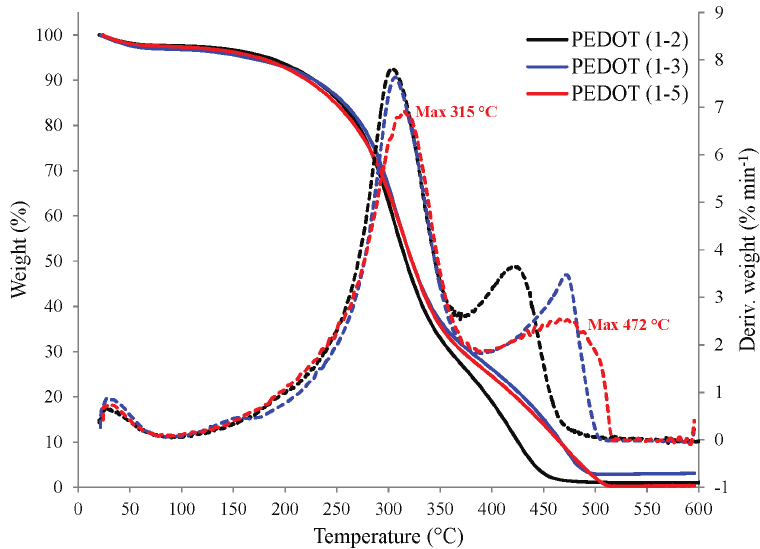
Fig. 3 – TG curves of PEDOT samples synthesized by various monomer to APS oxidant ratio (1:2, 1:3, 1:5)